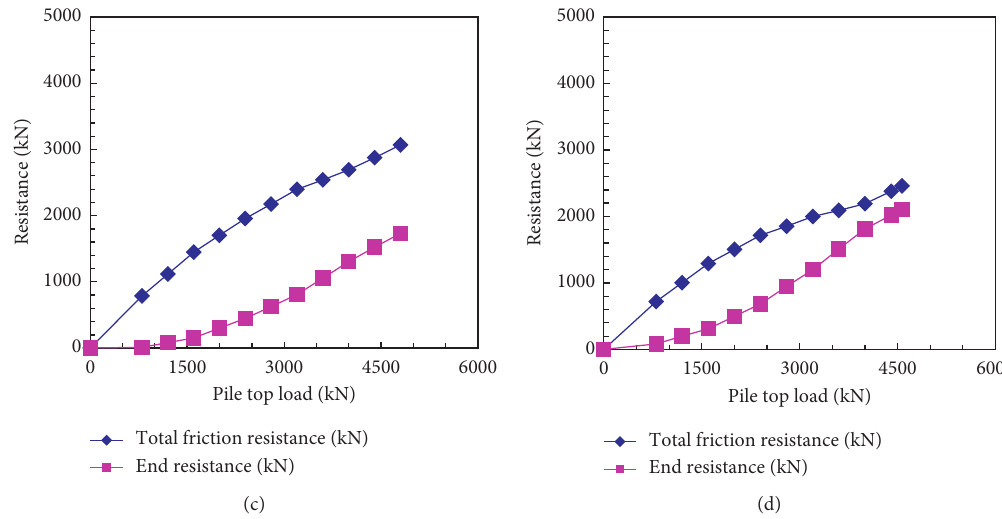
Figure 12: Illustration of relationships between total friction resistance and end resistance under various loads (at the hard rock bearing stratum site). (a) Pile #7. (b) Pile #8. (c) Pile #10. (d) Pile